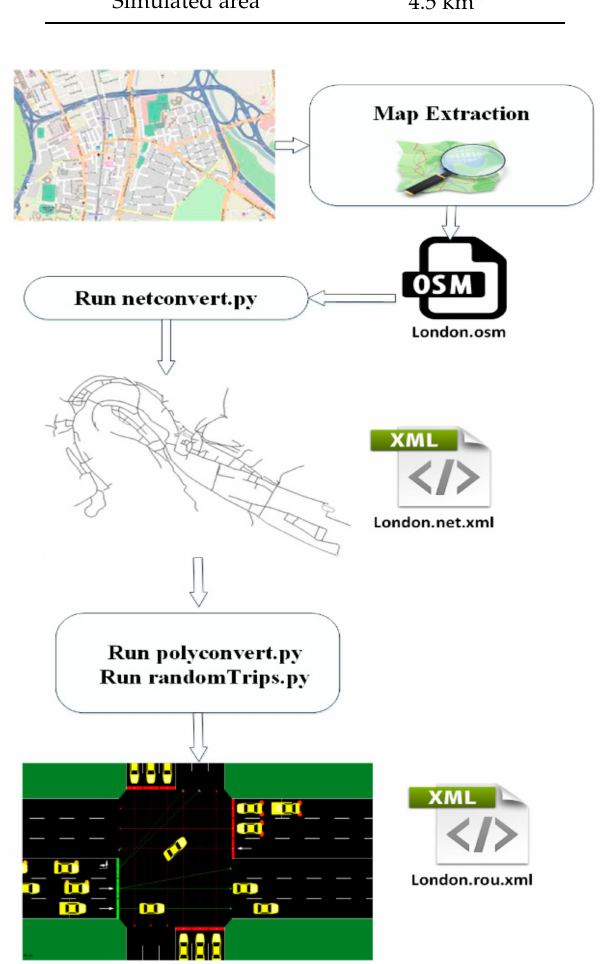
Figure 4. Trip generation using Sumo and OpenStreetMap